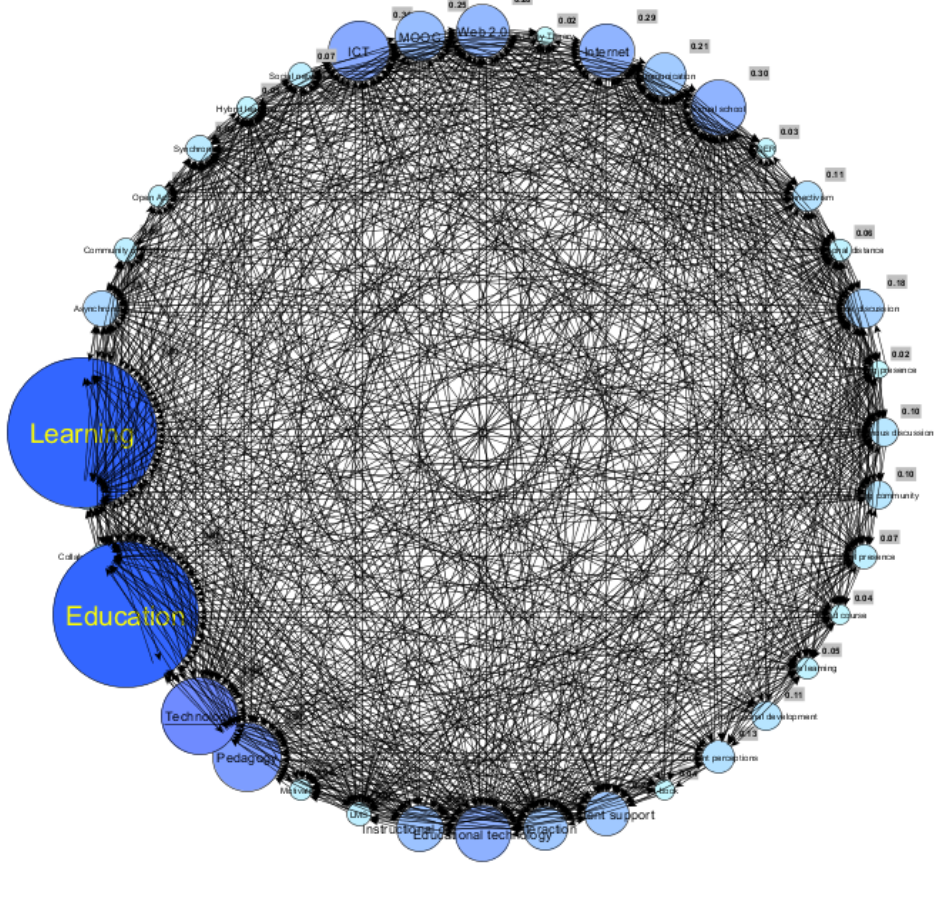
Figure 3 . A circular node betweenness centrality diagram